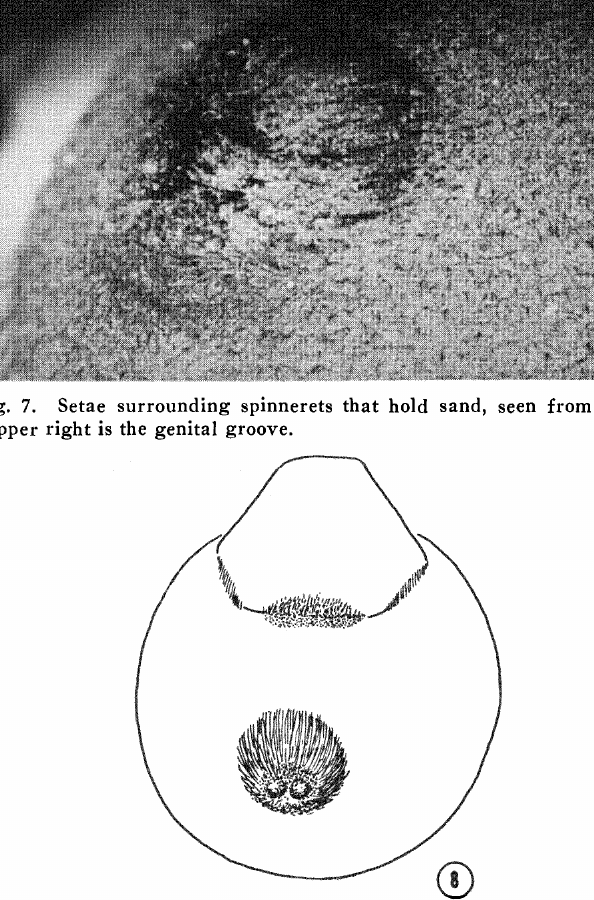
Fig. 8. Diagram of renter of female Loxosceles abdomen showing the long setae around and almost completely covering the spinnerets. The genital groove also has dense